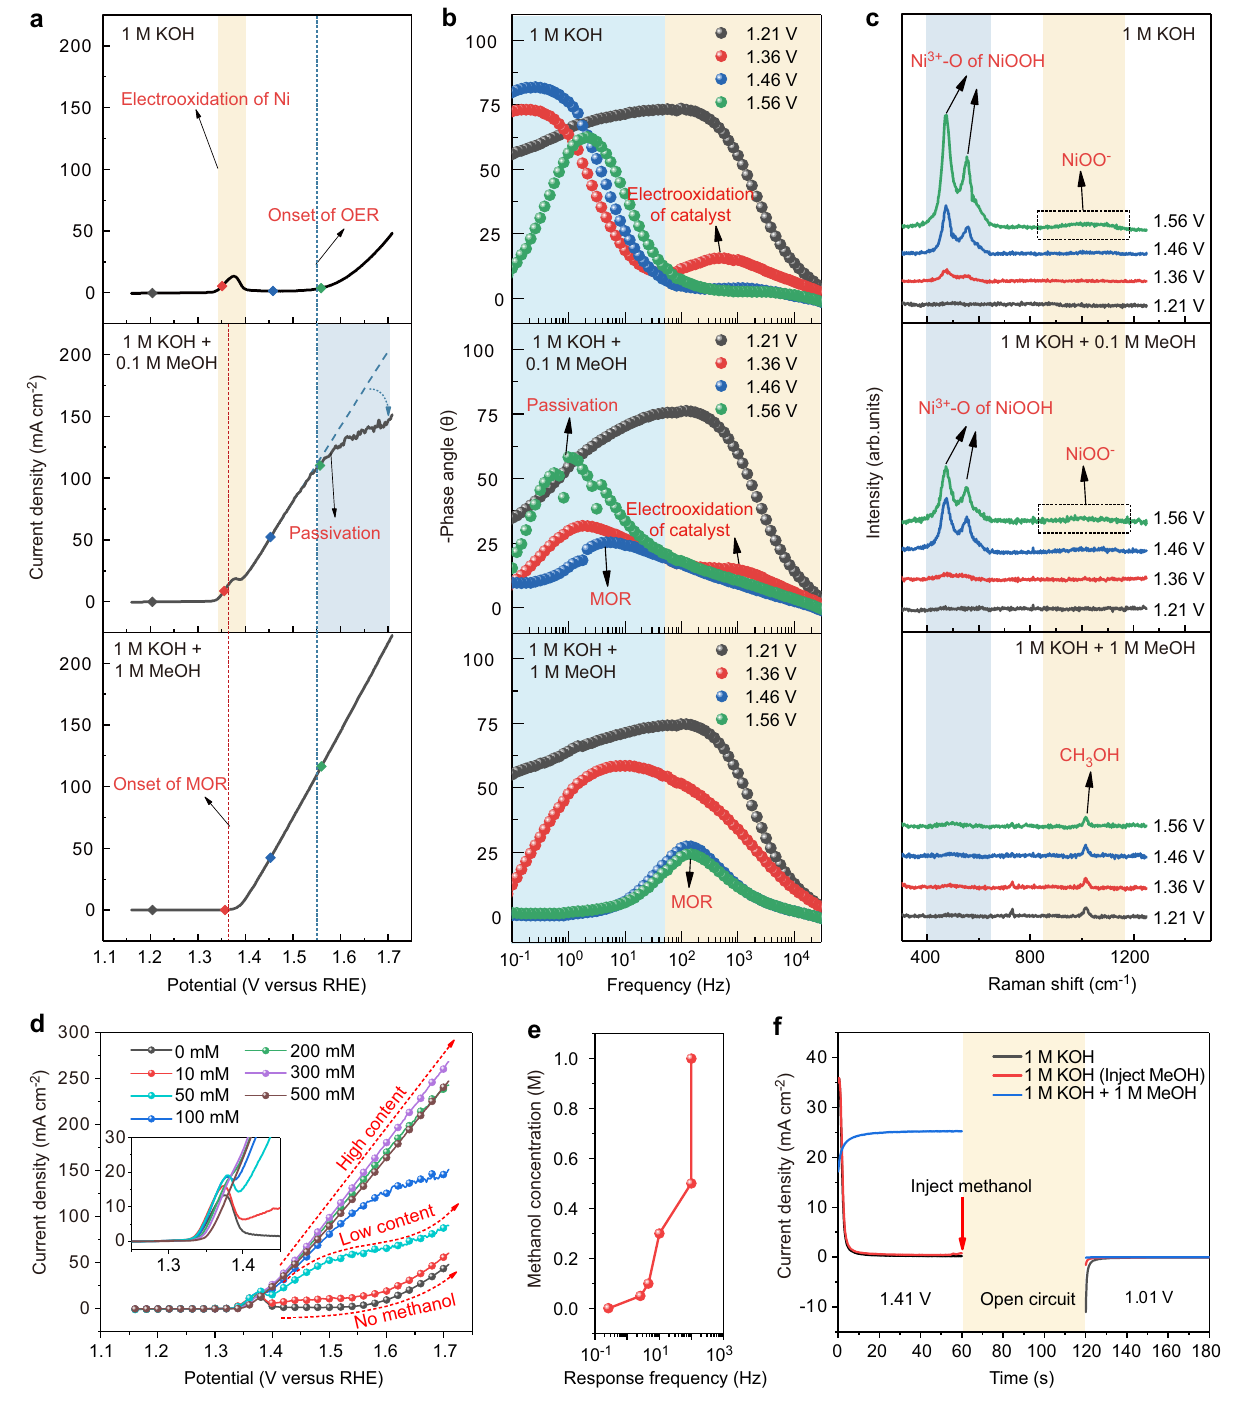
e Theresponsefrequencyofthereactionat1.41VintheBodeplotsasafunctionof methanol concentration. f Periodic electrochemical measurement over NiB-400. Source data are provided as a Source Data fi